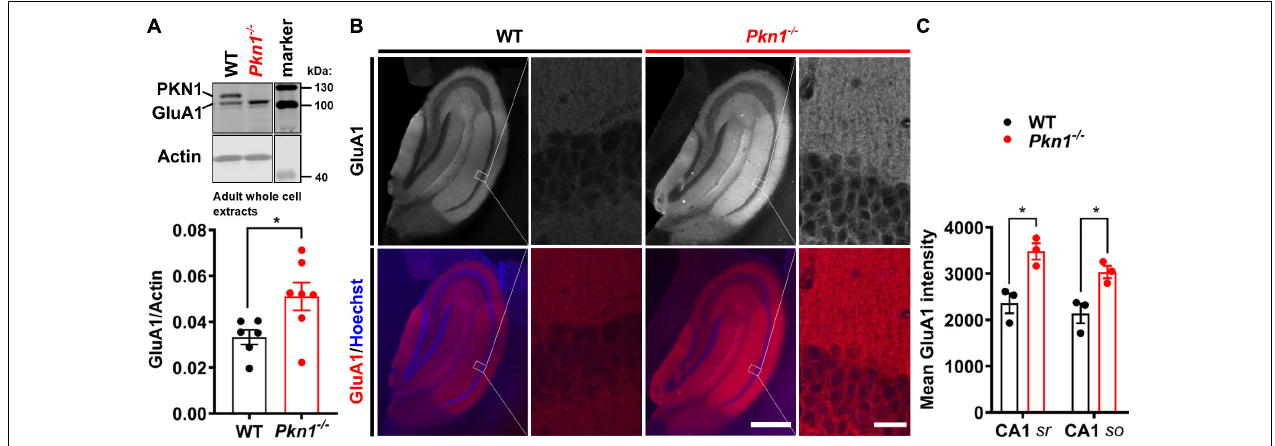
FIGURE 2 | Adult Pkn1 − / − animals have enhanced GluA1 protein levels (A) Whole cell protein extracts from adult WT and Pkn1 − / − hippocampi were prepared, probed for GluA1 and the ratio to the loading control actin was calculated (* P = 0.0321, unpaired t -test). The marker in the representative blot is shown in a separate lane as samples were not directly next to the marker in the blot. (B) Hippocampal GluA1 levels were further assessed by immunofluorescence staining. Pictures are representative of 3 animals/genotype. Scale bar in overview images refers to 500 µ m and scale bar in high resolution inserts refers to 20 µ m. (C) The mean intensity of hippocampal GluA1 levels from (B) was quantified in Fiji. CA1 sr refers to CA1 stratum radiatum, CA1 so refers to CA1 stratum oriens. (CA1 sr * P = 0.0156, unpaired t -test, CA1 so * P = 0.0233, unpaired t -test). All data is presented as individual n -values with mean ±